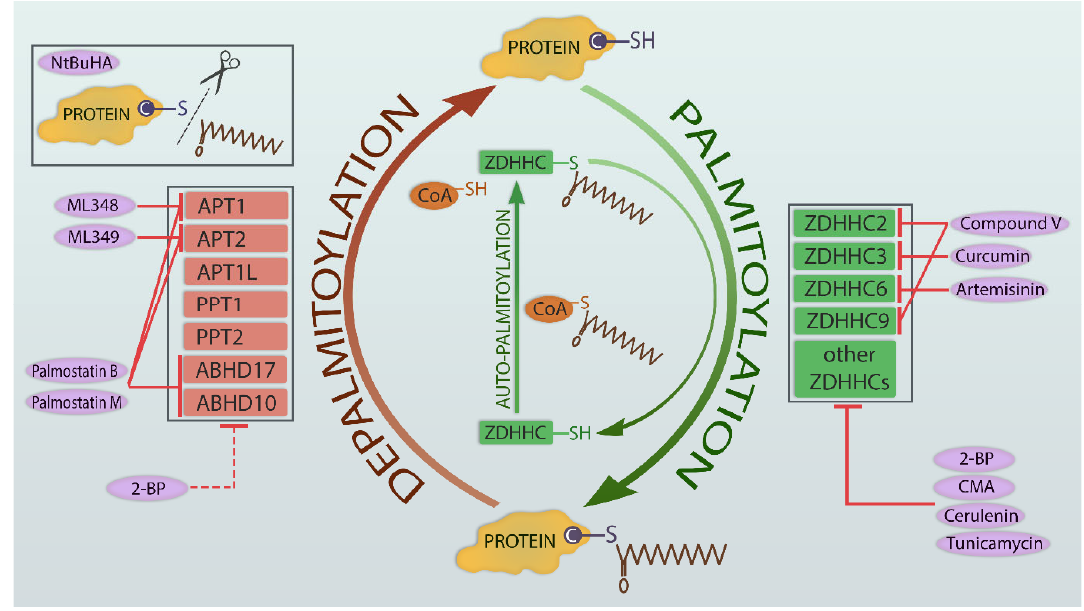
Figure 1. Symbolic illustration of the palmitoylation/depalmitoylation cycle with key enzymes and their inhibitors. S-palmitoylation of the substrate protein is preceded by the auto-acylation of the ZDHHC enzymes (middle panel). The palmitoyl group is moved from the palmitoyl-CoA molecule onto the cysteine residue of ZDHHC, creating an intermediate state. Then, the fatty acyl group is moved into the thiol group of a cysteine residue of a substrate protein (right panel). The reverse process of removing the palmitoyl group from protein (depalmitoylation) is catalyzed by palmitoyl-protein thioesterases (left panel). The inhibitors of enzymes are shown in purple oval